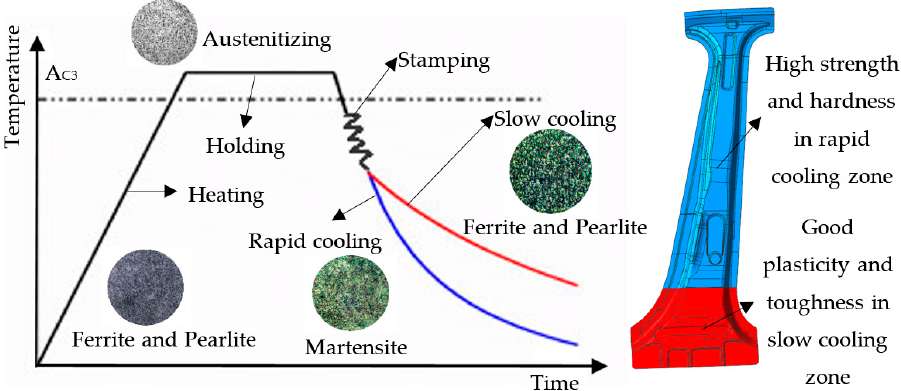
Figure 2. The principle and procedures of the hot stamping process.